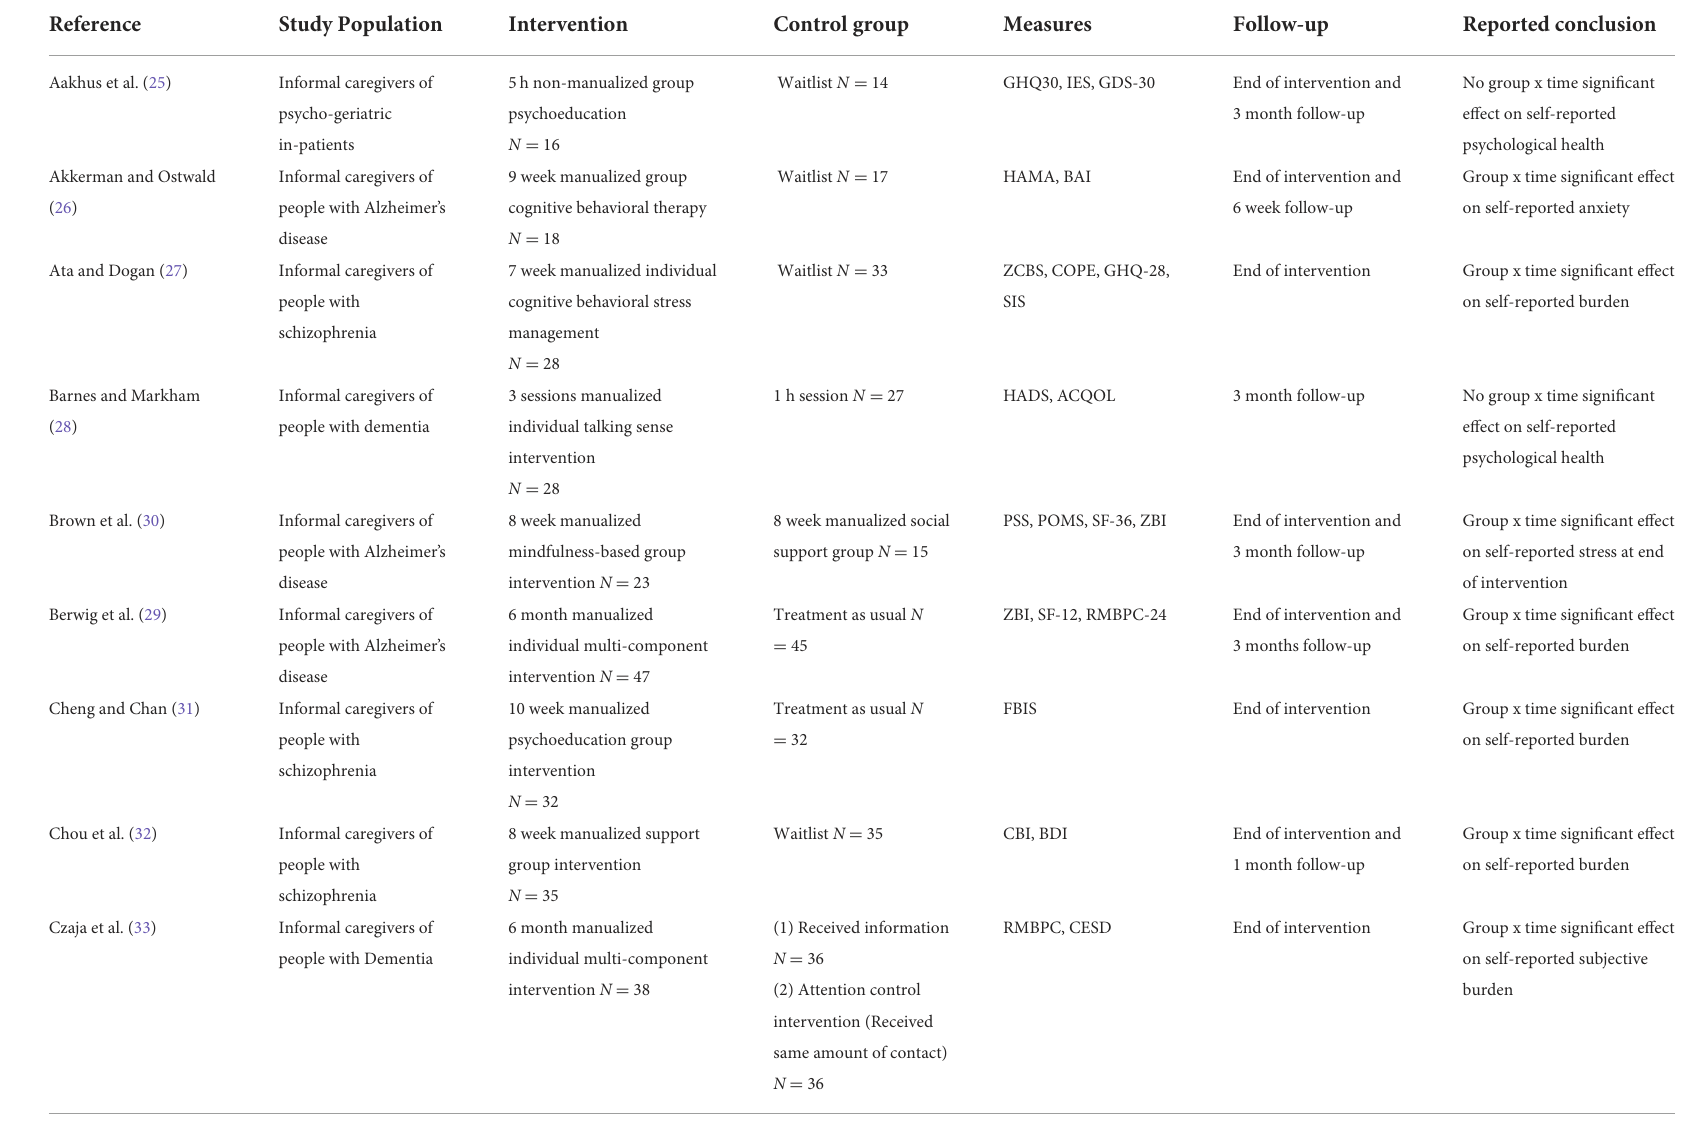
TABLE 1 Overview of all included